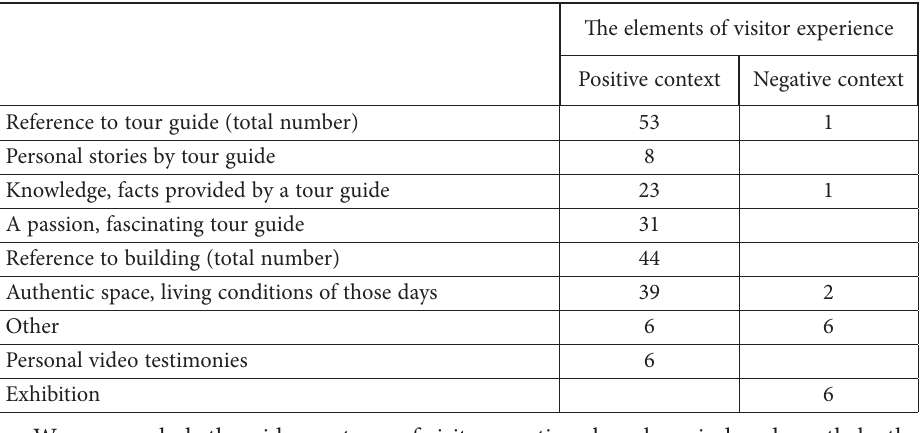
Table 2. Frequency count of product design elements from the perspective of Committee State Security Building visitors (source: created by